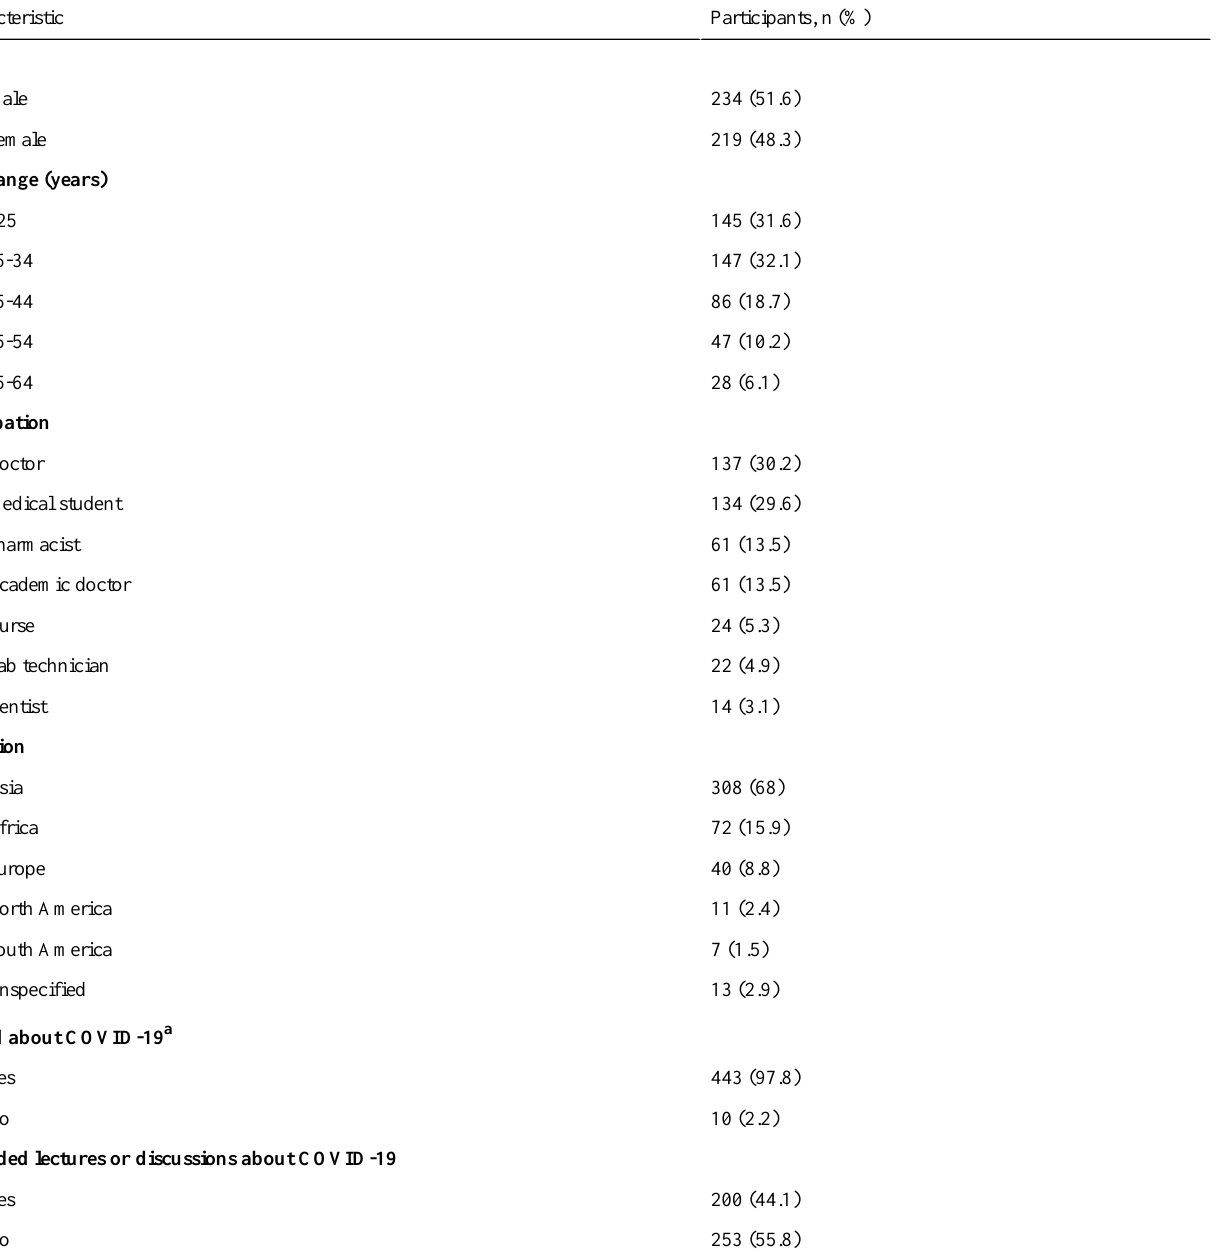
Table 1. Sociodemographic characteristics of health care workers (N=453).